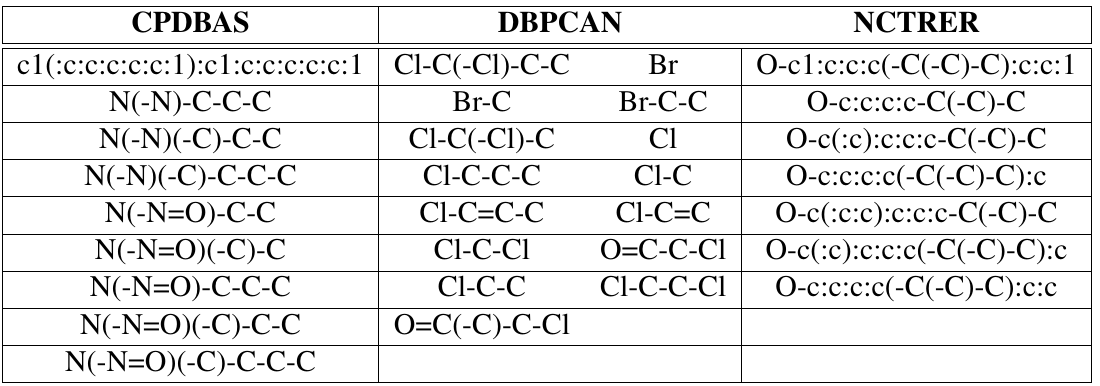
Table 4: Some molecular fragments discovered by Moss in SMILES [14]